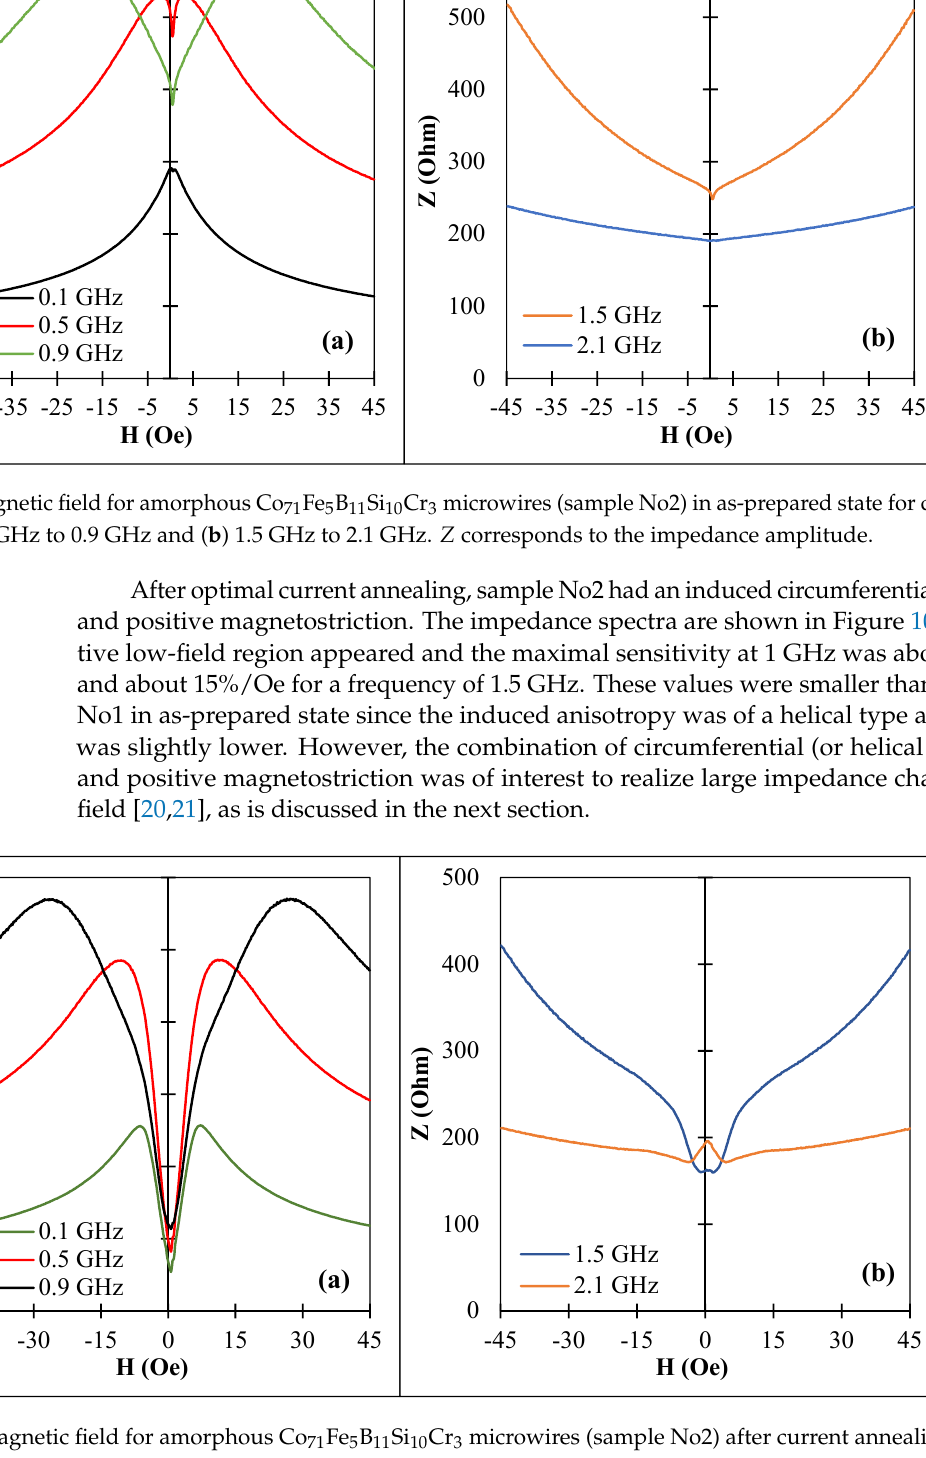
Figure 10. MI vs. magnetic field for amorphous Co 71 Fe 5 B 11 Si 10 Cr 3 microwires (sample No2) after current annealing with I an = 60 mA for 30 min at GHz frequency range: ( a ) 0.1 GHz to 0.9 GHz and ( b ) 1.5 GHz to 2.1 GHz. Z corresponds to the impedance amplitude.